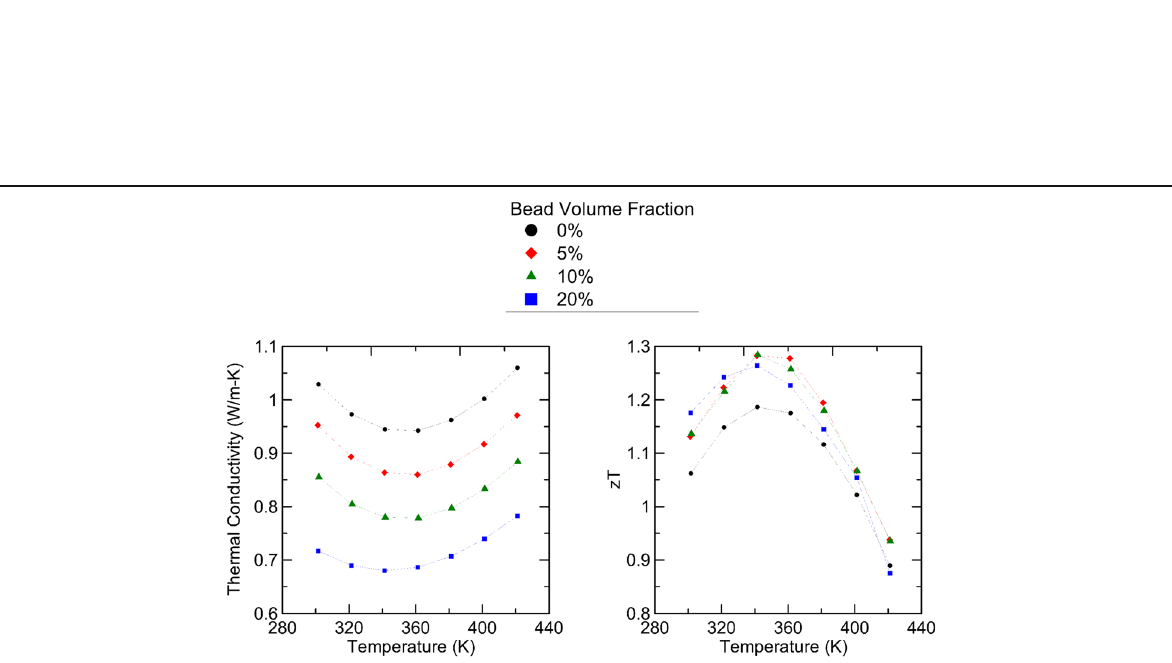
Fig. 3 Thermal conductivity and ZT of a composite made of Pb-coated glass beads in a (Bi 0.25 Sb 0.75 ) 2 Te 3 host matrix. The temperature dependence of κ and ZT are shown. ZT clearly is enhanced in the 5% composite over the values of the bulk host